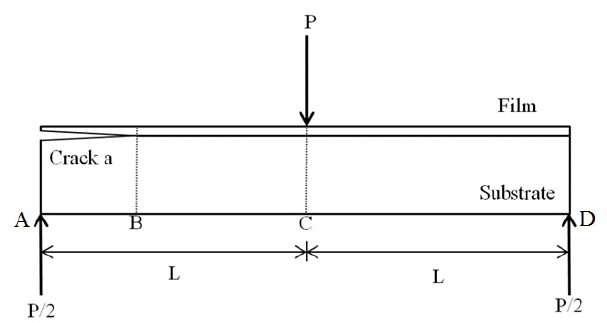
Figure 2. Three-point bending test on end-notched flexure (ENF) specimen.